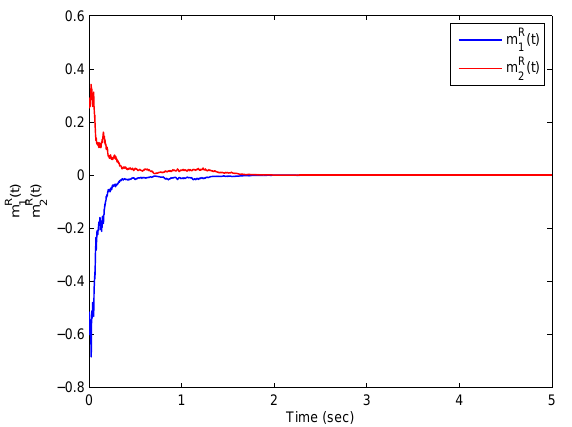
( t ) , m R ( t ) pertaining to the SMQVNN 2 1